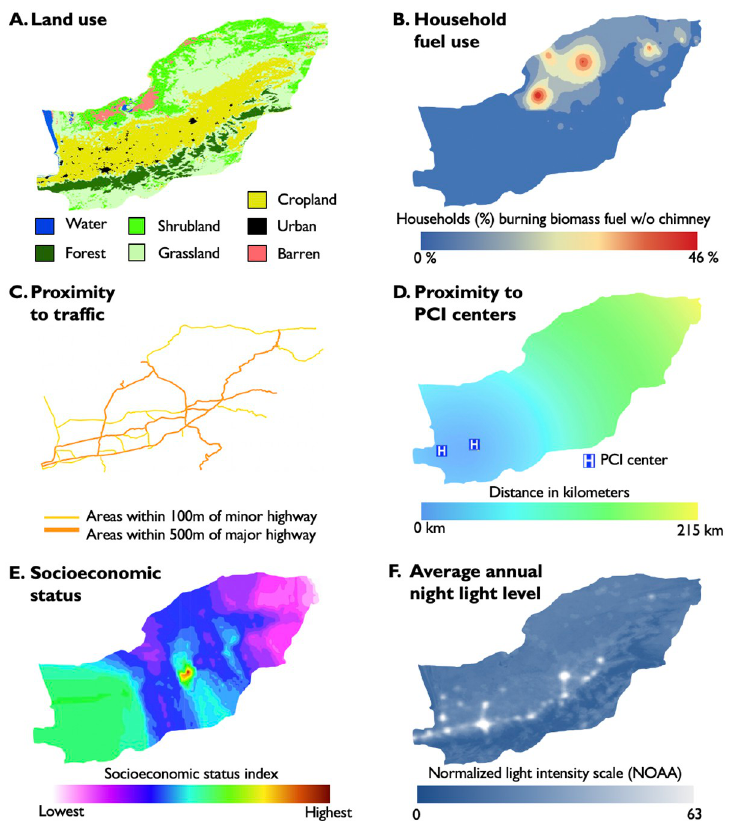
Fig 2. Spatial models for six spatial environmental factors (SEFs) across Golestan Province, Iran. These models were used to assign environmental exposures to individuals based on their location of residence. Methodologies are described in S1 Table in S1 File. A. Land use based on satellite imagery [28]. B. Proportion of households burning biomass fuels without a chimney. Estimates derived from Gaussian process regression (kriging) of average fuel use patterns for each village geocode [20]. C. Proximity to traffic, defined as within 100m of a minor highway or within 500m of a major highway [20]. D. Proximity to percutaneous coronary intervention centers [20]. E. Average socioeconomic status index score. Estimates derived from kriging of median socioeconomic score for each geocode [23]. F. Average annual intensity of light-at-night using satellite imagery [27]. Models developed in ArcGIS [38]. All displayed data is either in the public domain, collected by the investigators, or for illustrative purposes